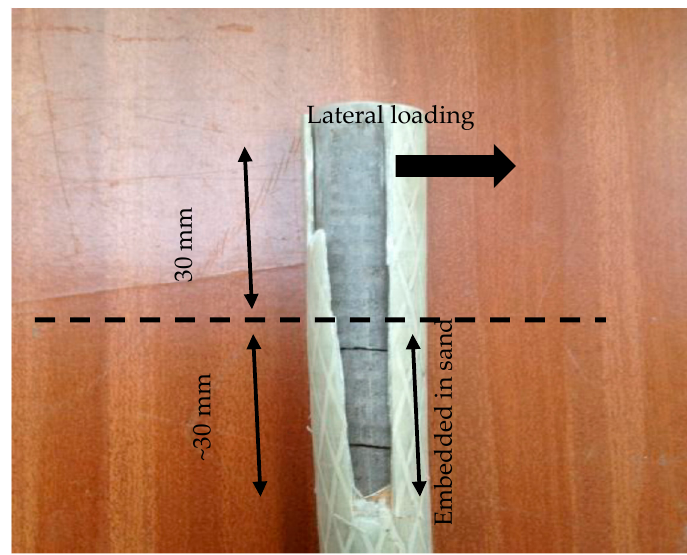
Figure 11. Aging effect on GFRP piles under a lateral load ( a ) and aging effect on CFRP piles under a lateral load ( b ).